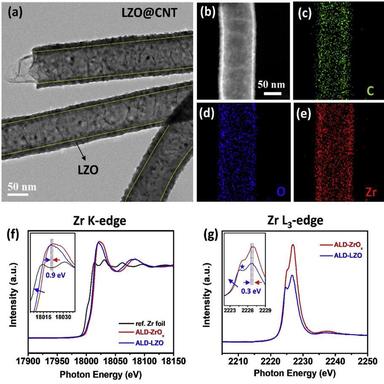
Characterizations of the prepared ALD-LZO film on CNTs. (a) a TEM image of the deposited LZO films on CNTs (LZO@CNT); (b) a STEM image of the LZO@CNT material; (c–e) EDX mapping of the C, O, and Zr elements on the LZO@CNT; (f and g) comparison of the XANES of Zr K-edge and L3-edge spectra between the ALD deposited ZrOx and LZO films.